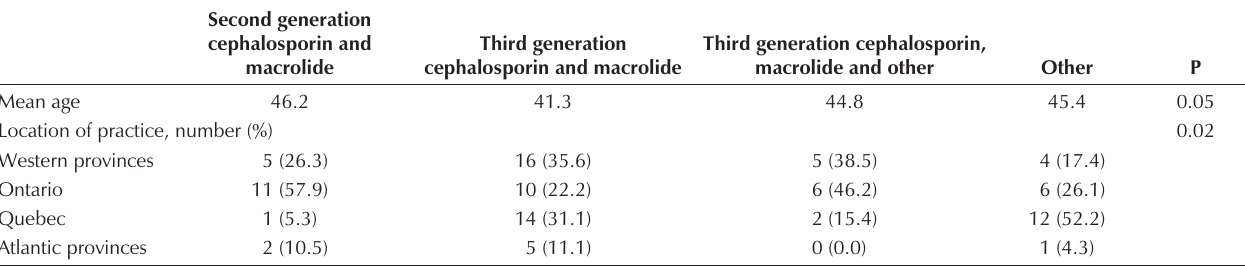
Relationship between choice of antibiotics for case 3 and respondent age and location of practice Second generation cephalosporin and macrolide